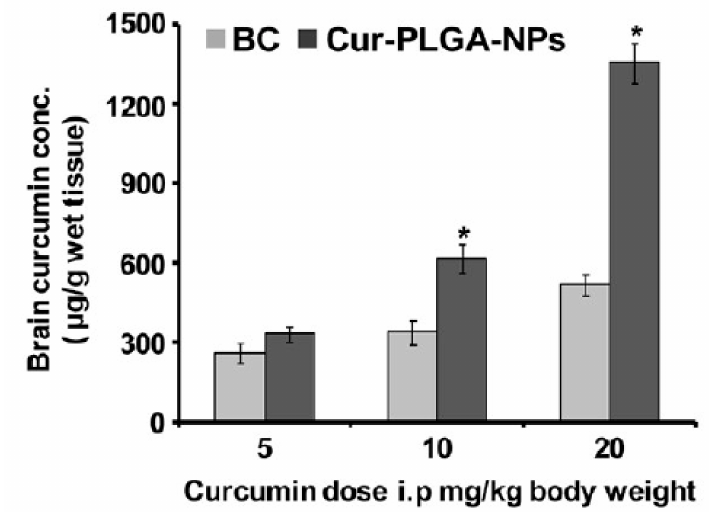
Figure 7. Concentration of drug in the brain for different dosages of uncoated bulk curcumin (BC) and curcumin/PLGA nanoparticles. * p < 0.05 versus BC [24]. Reproduced from [24] with permission from American Chemical